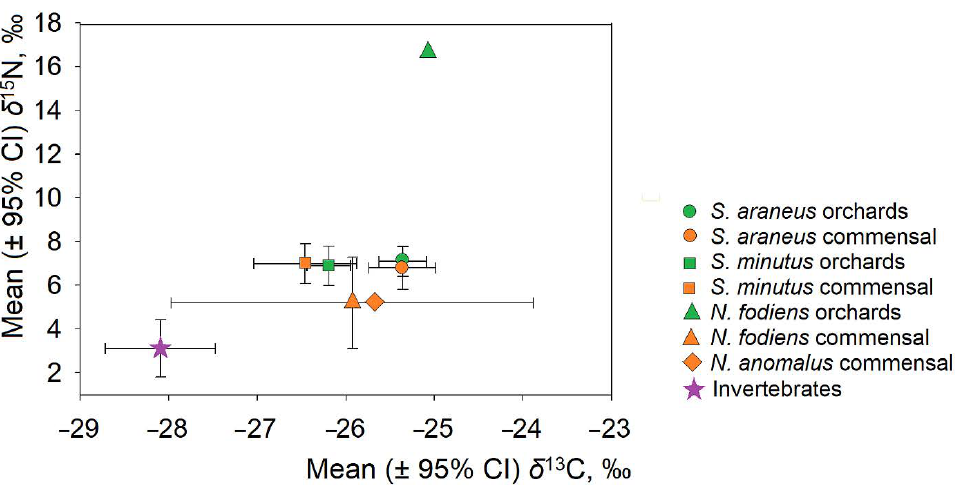
Figure 2. The position of insectivorous species and their possible prey in isotopic space according to stable isotope ratios of hair samples from commercial fruit farms and commensal